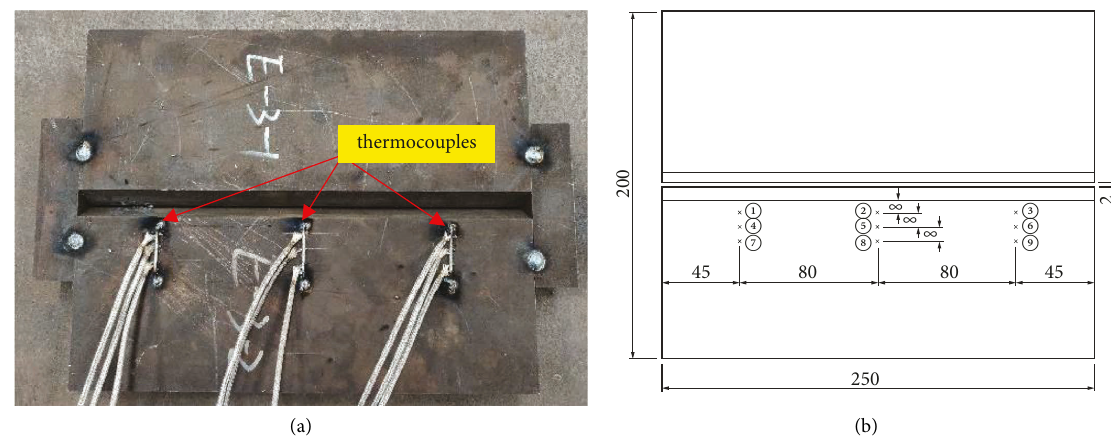
Figure 3: Thermocouples layout (unit: mm). (a) Attached thermocouples of specimens. (b) Schematic diagram of measuring points.